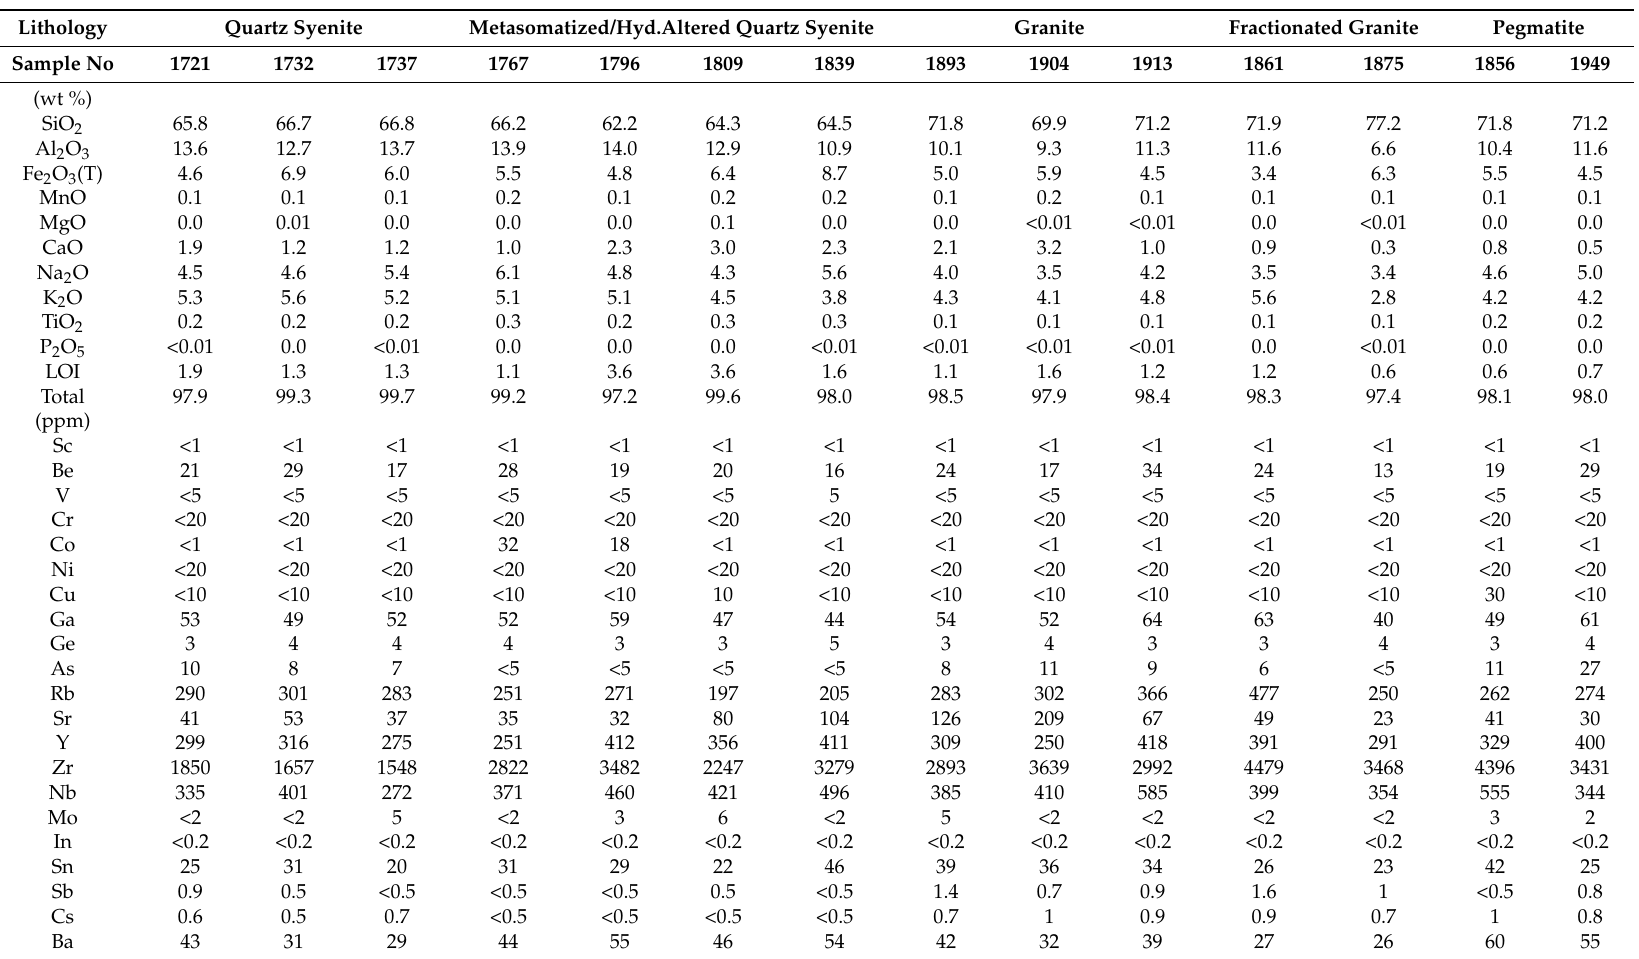
Table A1. Major and trace element data of representative Khaldzan Burgedei